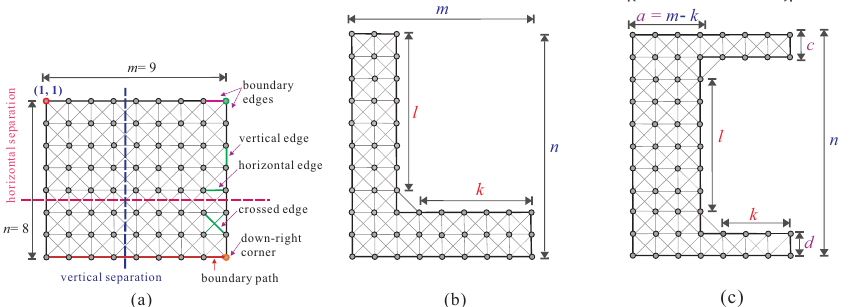
Figure 3. ( a ) A rectangular supergrid graph R ( 9,8 ) , where the bold dashed lines indicate vertical and horizontal separations, ( b ) the structure of L -shaped supergrid graph L ( 9,11;6,8 ) , and ( c ) the structure of C -shaped supergrid graph C ( 8,11;4,7;2,2 )